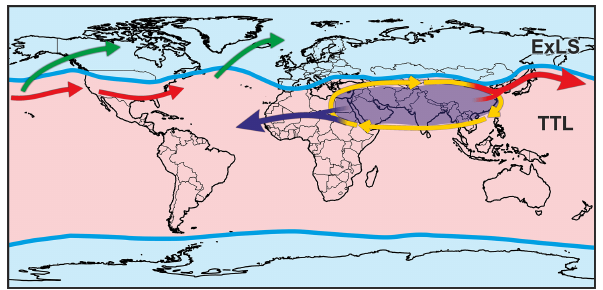
Figure 16. Horizontal transport pathways from the Asian monsoon anticyclone and the surrounding air masses (yellow) westward into the tropical tropopause layer (blue arrow) and eastward along the subtropical jet (red arrows). Cross-tropopause transport into the ex- tratropical lower stratosphere occurs mainly above the Atlantic and Pacific oceans and is most likely driven by Rossby wave breaking events (green